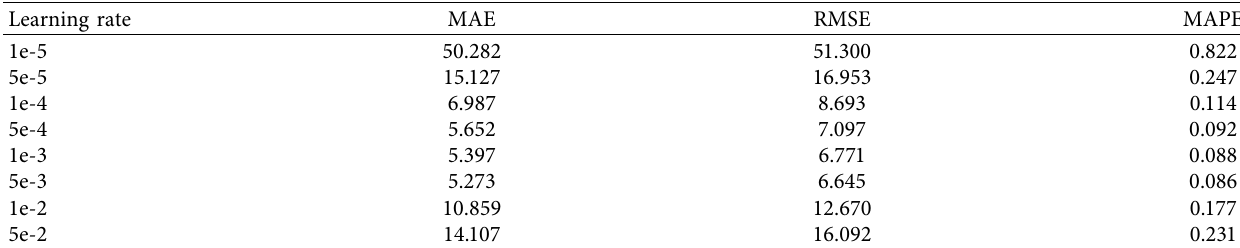
Table 4: The performance of AGBO under different learning